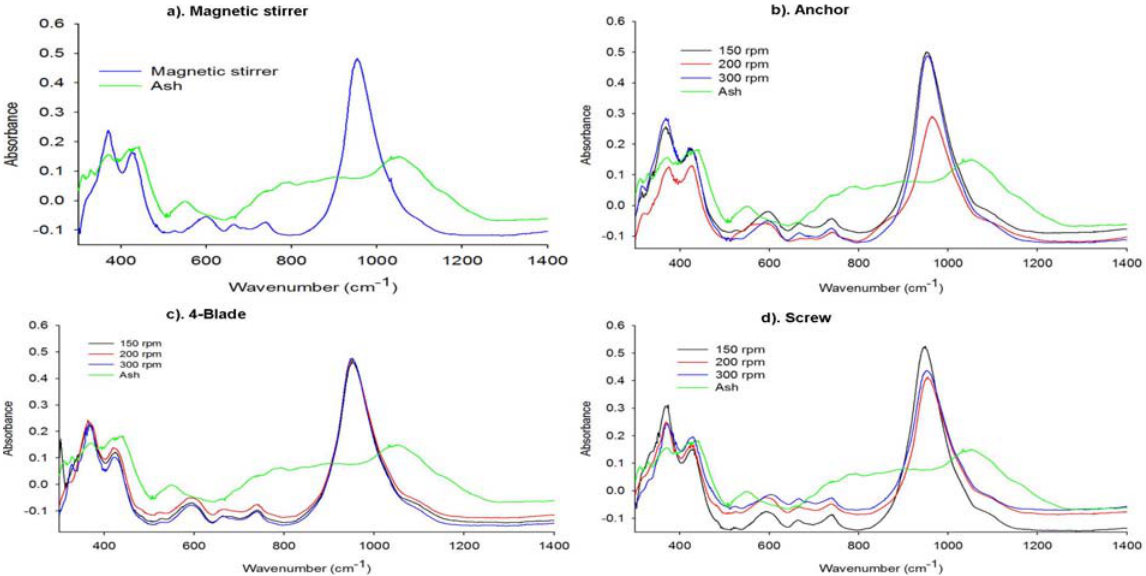
Figure 4. FTIR spectra of the zeolitic products synthesized using different impellers with variation of stirring